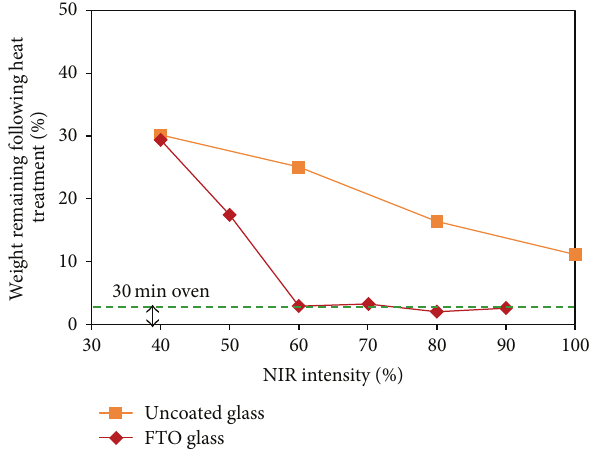
Figure 3: Weight of material remaining in the TiO 2 paste as measured by thermogravimetric analysis of 12.5 s NIR exposed TiO 2 paste on FTO glass and uncoated glass. The weight loss observed for a 30-minute oven treatment is shown as a dotted line